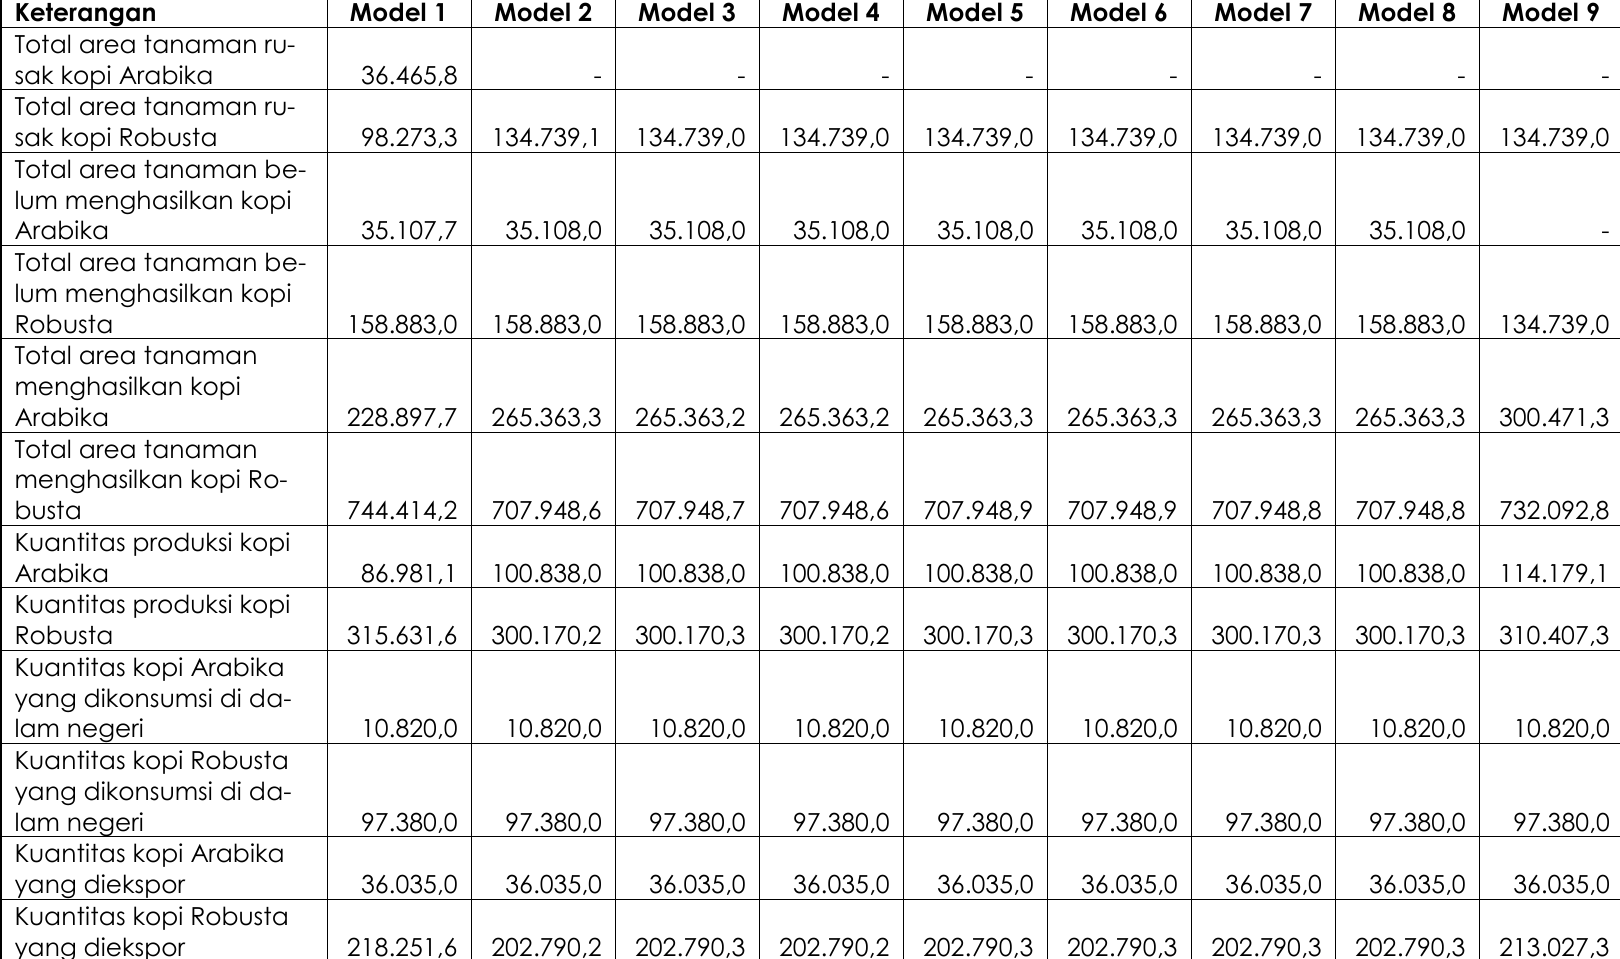
Tabel 2: Nilai Variabel Keputusan Pada Berbagai Model Goal